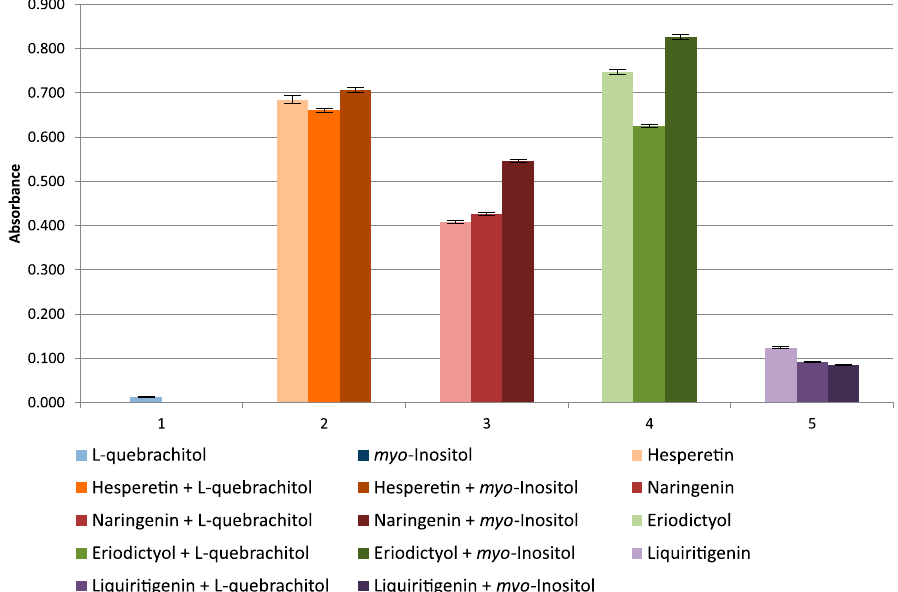
Figure 2. Absorbance change graph of L -quebrachitol, myo -inositol, flavanones and their mixtures with cyclitols.